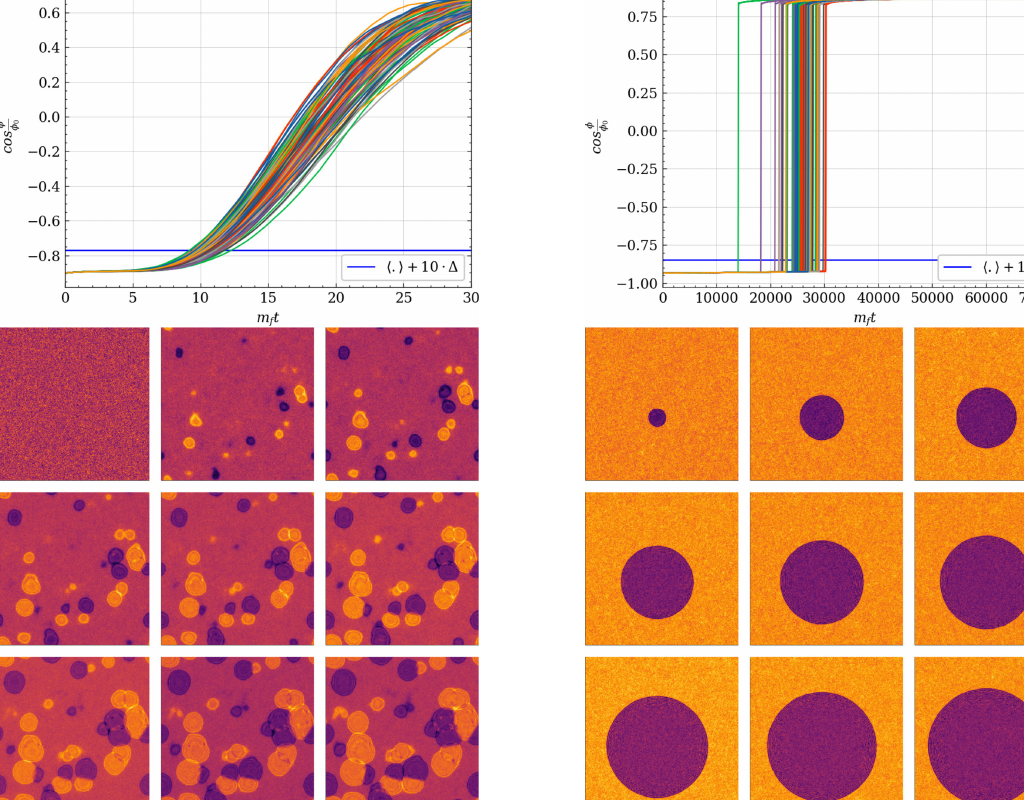
Figure 16 . The time evolution of h cos( φ/φ 0 ) i (top) for (cid:15) = 1 . 0 (left) and (cid:15) = 0 . 5 (right), both at φ = 1 . 2 . Below are example configurations, with snapshots at different times in the evolution, 0 again for (cid:15) = 1 . 0 (left) and (cid:15) = 0 . 5 (right). The simulation parameters are N